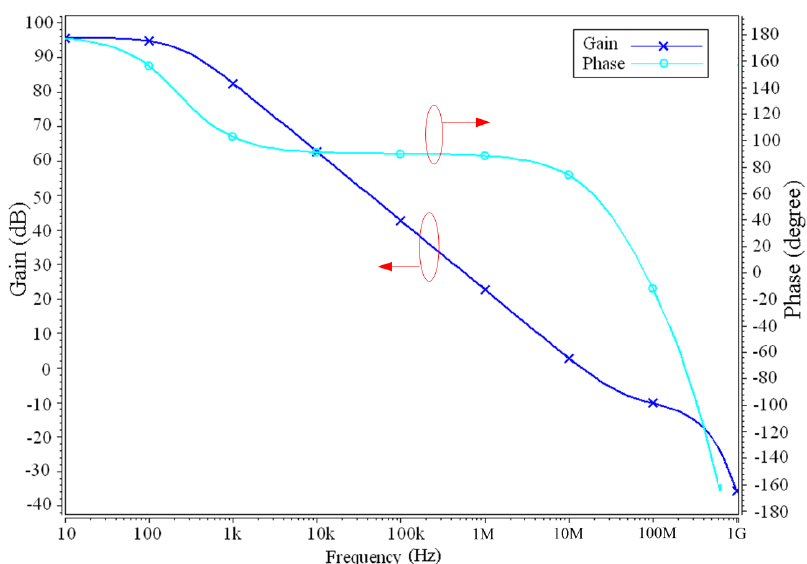
Figure 9. Frequency response of the operational